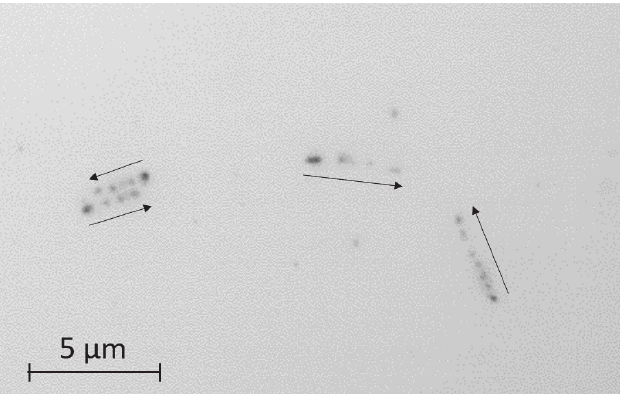
Figure 1. Typical track image of the nuclear emulsion. The arrows show the tracking